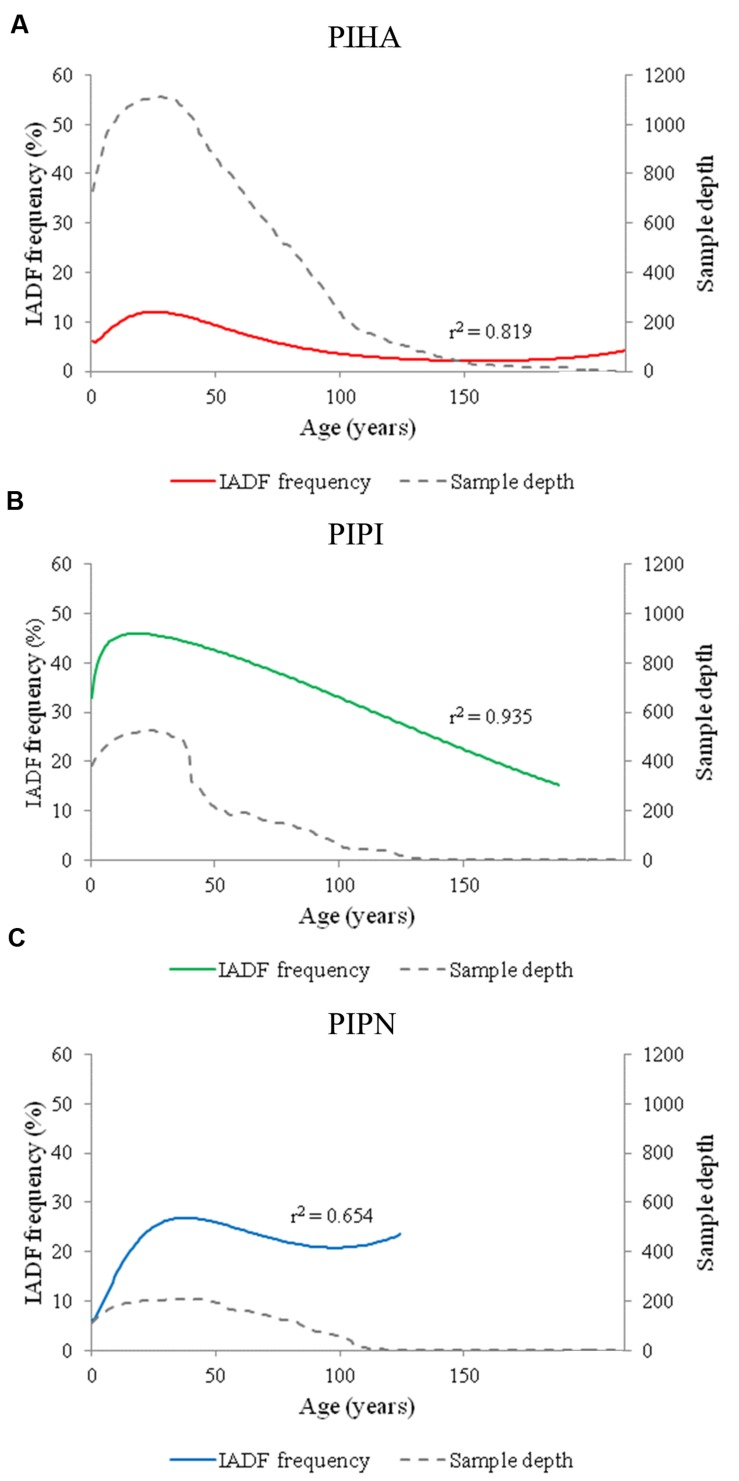
Logistic binomial regressions between IADF frequency and tree-ring age for the three species (PIHA, Pinus halepensis; PIPI, Pinus pinaster; PIPN, Pinus pinea). Population structure and IADF frequency for (A)
Pinus halepensis (PIHA), (B)
Pinus pinaster (PIPI), and (C)
Pinus pinea (PIPN). Age refers to tree-rings aligned from the most juvenile to the oldest ones.